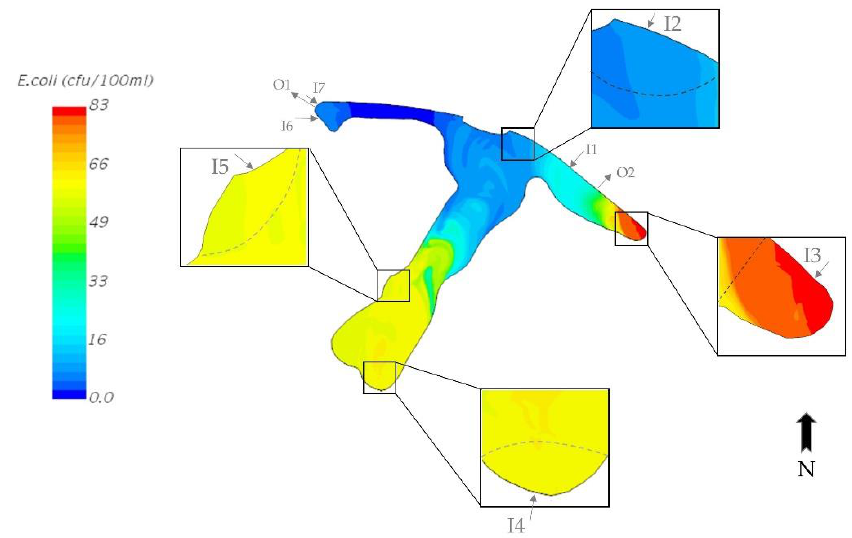
Figure 8. E.coli distribution on the surface 27 August 2007 at 2 a.m. (9 h after the end of the storm).